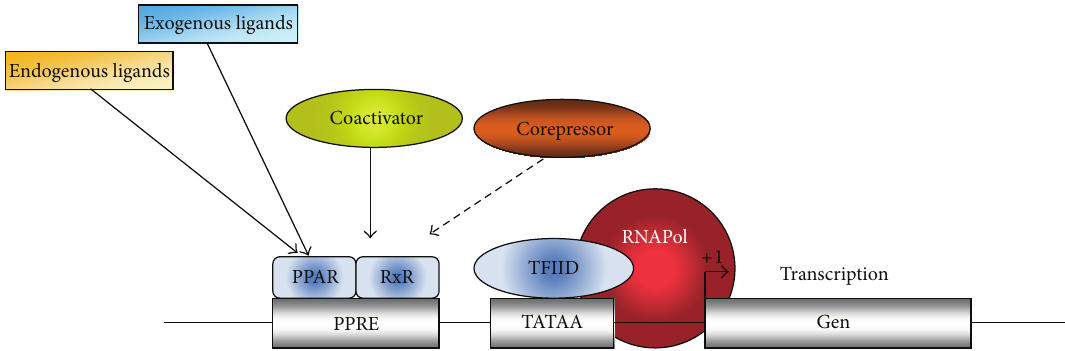
Figure 2: Gene transcription mechanisms of PPAR. In inactivated state, PPAR interacts with the corepressor, and this complex has Histone deacetylase activity, thus inhibiting the transcription process. After the binding of the exogenous ligand (drug) or endogenous ligand (fatty acids, prostaglandins, etc.), with the PPAR it is activated and it heterodimerizes with RXR and recruits coactivators, which have histone acetylase activity facilitating the transcription of several